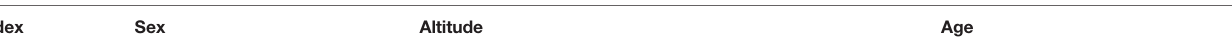
TABLE 2 | Effect of sex, altitude, and age on thyroid-associated